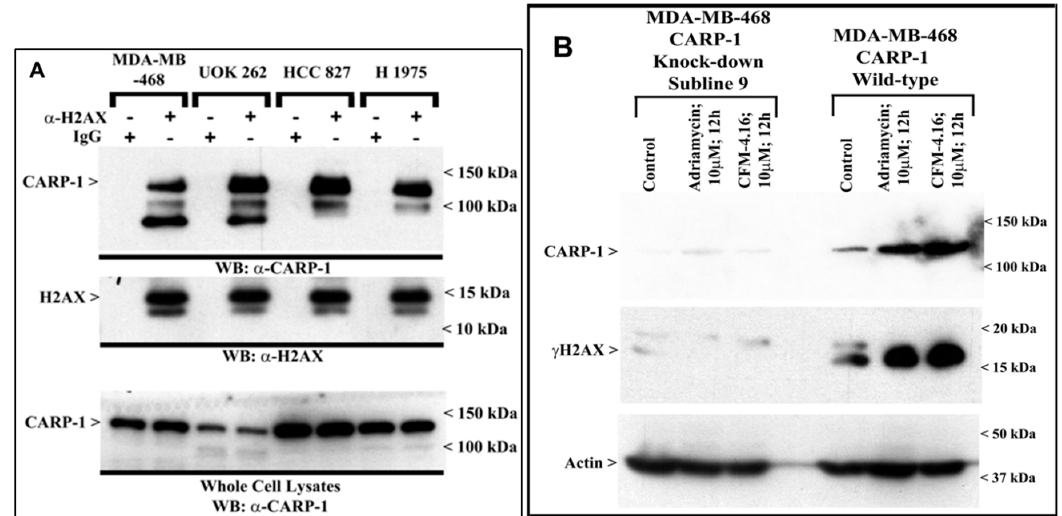
Figure 3. CARP-1 interacts with H2AX, and knock-down of CARP-1 abrogates γ H2AX following treatments with Adriamycin or CFM-4.16. ( A ) Approximately 1 mg of cell lysate from each of the indicated cells was subjected to immunoprecipitation using anti-H2AX antibodies. The immunoprecipitates were then analyzed with WB by probing the membrane with anti-CARP-1 ( α 2) antibodies (top autoradiograph). The membrane was subsequently re-probed with anti-H2AX antibodies to ascertain presence of H2AX (middle autoradiograph). The whole-cell lysates were separately analyzed with WB to determine endogenous CARP-1 in the respective cell line (Lower autoradiograph). ( B ) Cells were either untreated (Control), or treated with Adriamycin or CFM-4.16 for noted dose and time. Cell lysates were analyzed with WB as described in Section 2 for levels of CARP-1 and γ H2AX. The WB membrane was subsequently probed with anti-actin antibodies to assess equal loading. The presence of respective proteins is indicated by an arrowhead on the left side of each blot. The approximate location of various molecular-weight markers is indicated on the right side of each blot; kDa, kilodalton.